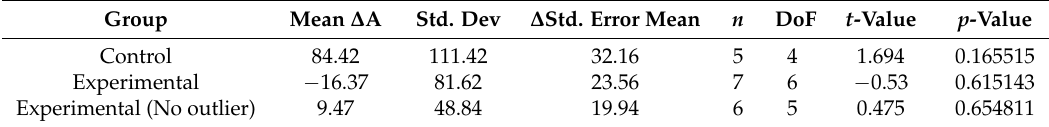
Table 2. Comparison of the statistical significance for both groups’ bodily surface area data.